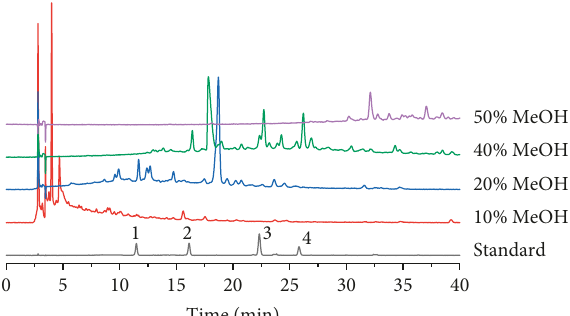
Figure 5: Comparison of HPLC chromatograms obtained using different compositions of methanol for analysis four phenylethanoid glycosides in LDC. (1) Purpureaside C, (2) jionoside A1, (3) acteoside, and (4) isoacteoside.